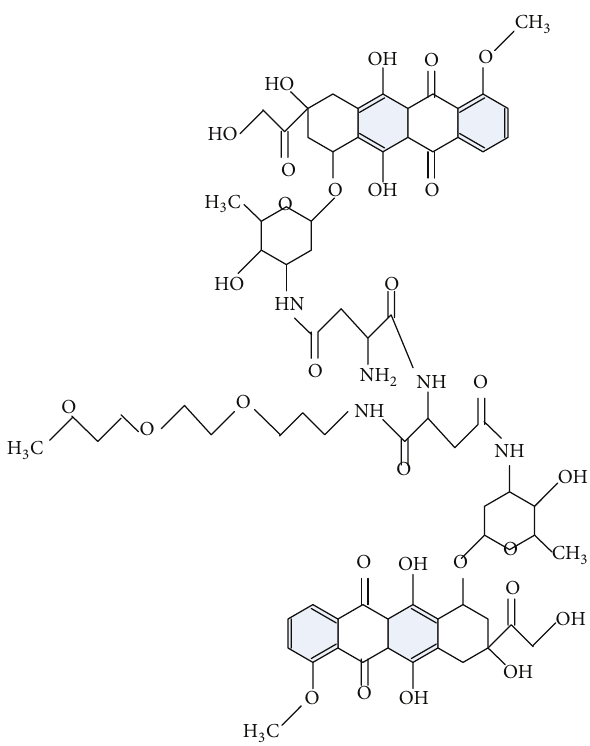
Figure 3: The molecular structure of 𝑆𝑃[2]